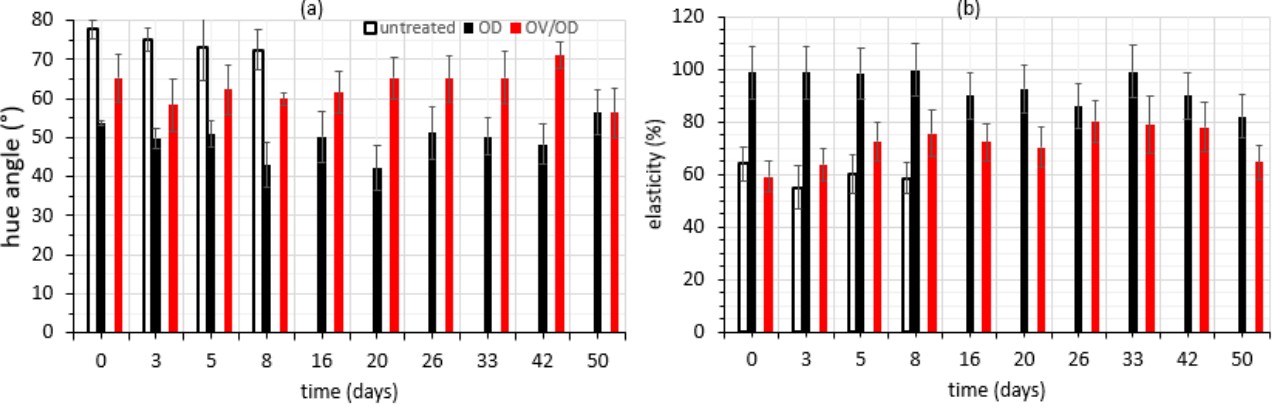
Figure 6. ( a ) Color changes expressed as hue angle and ( b ) elasticity alterations of all samples during storage at 4 °C. Error bars represent the ± standard deviation of multiple measurements.